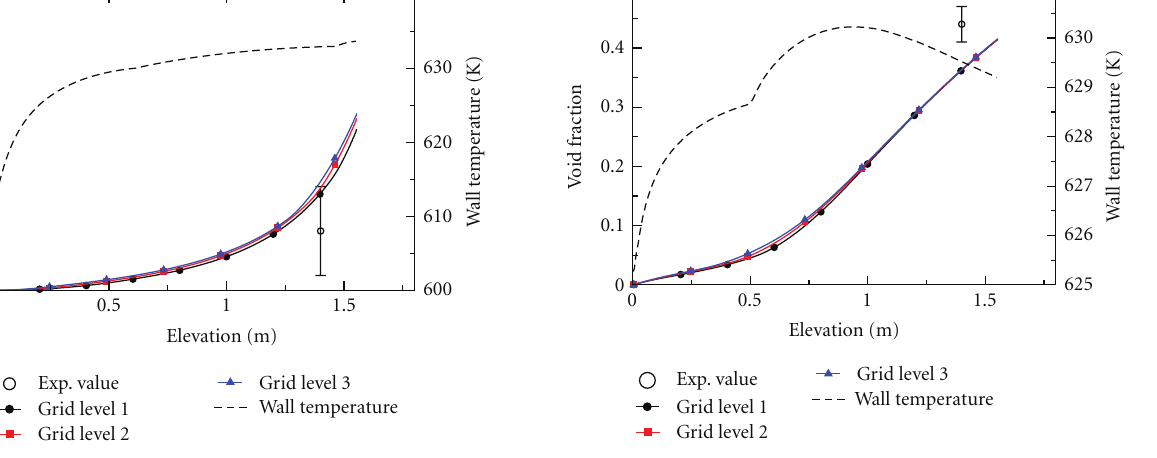
Figure 5: Run 1.2211. Axial evolution of the cross-section averaged void fraction for the 3 grid levels.